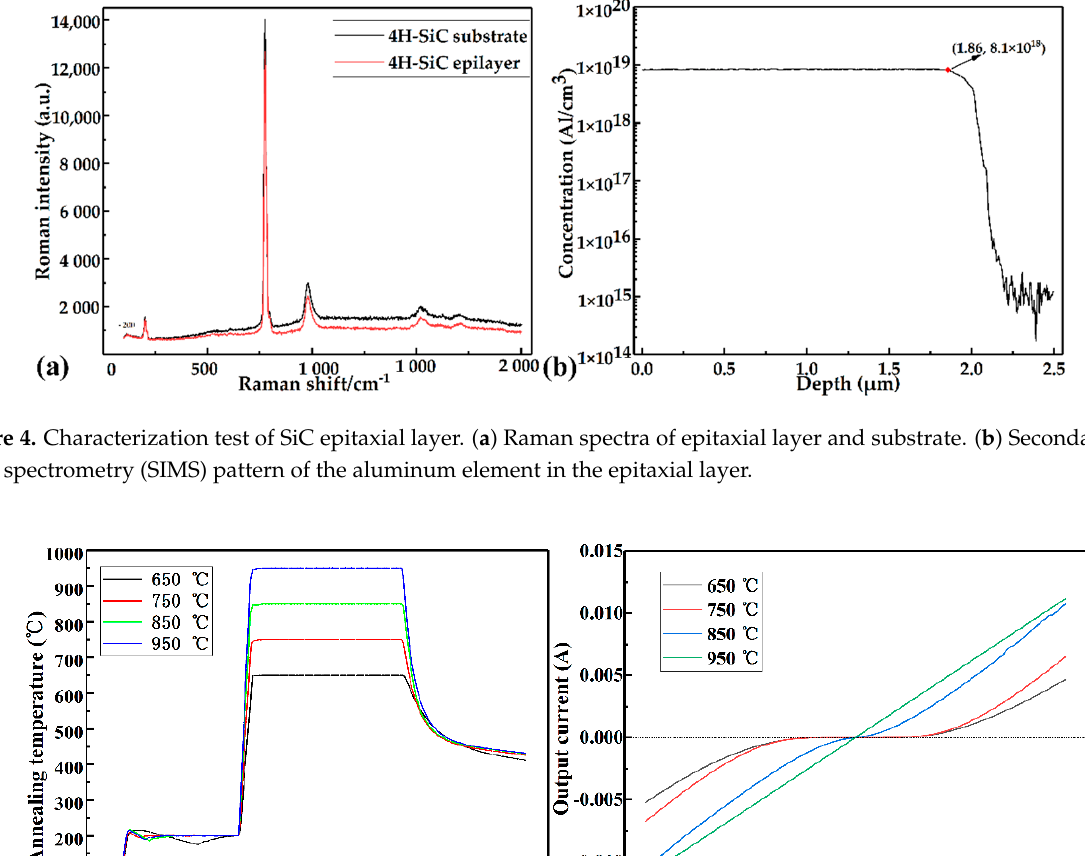
Figure 4. Characterization test of SiC epitaxial layer. ( a ) Raman spectra of epitaxial layer and sub- strate. ( b ) Secondary ion mass spectrometry (SIMS) pattern of the aluminum element in the epitax- ial layer.